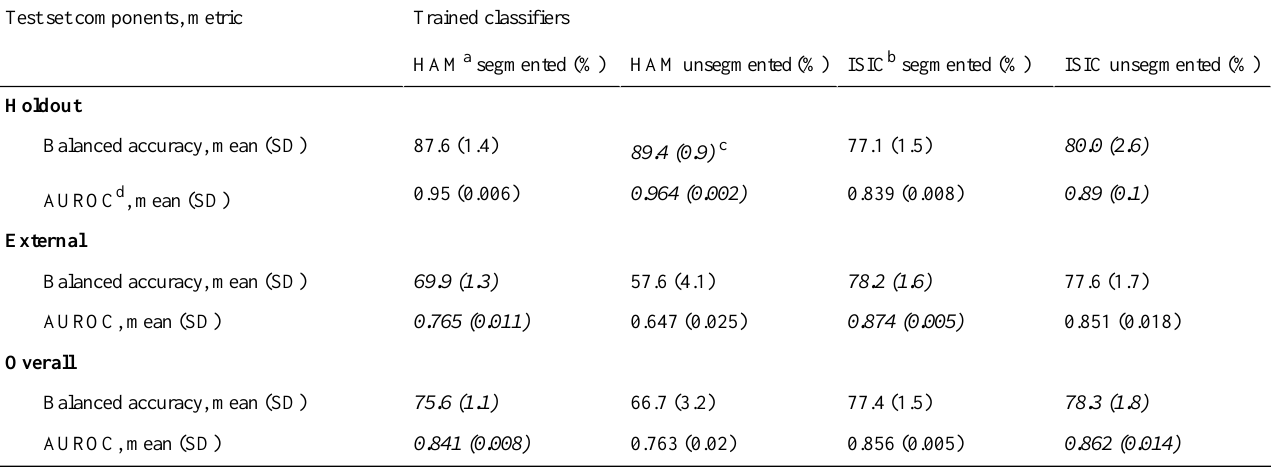
Table 1. Overview of the balanced accuracy and area under the receiver operating characteristic curve for each type of classifier across the holdout, external, and overall test set. Trained classifiersTest set components,